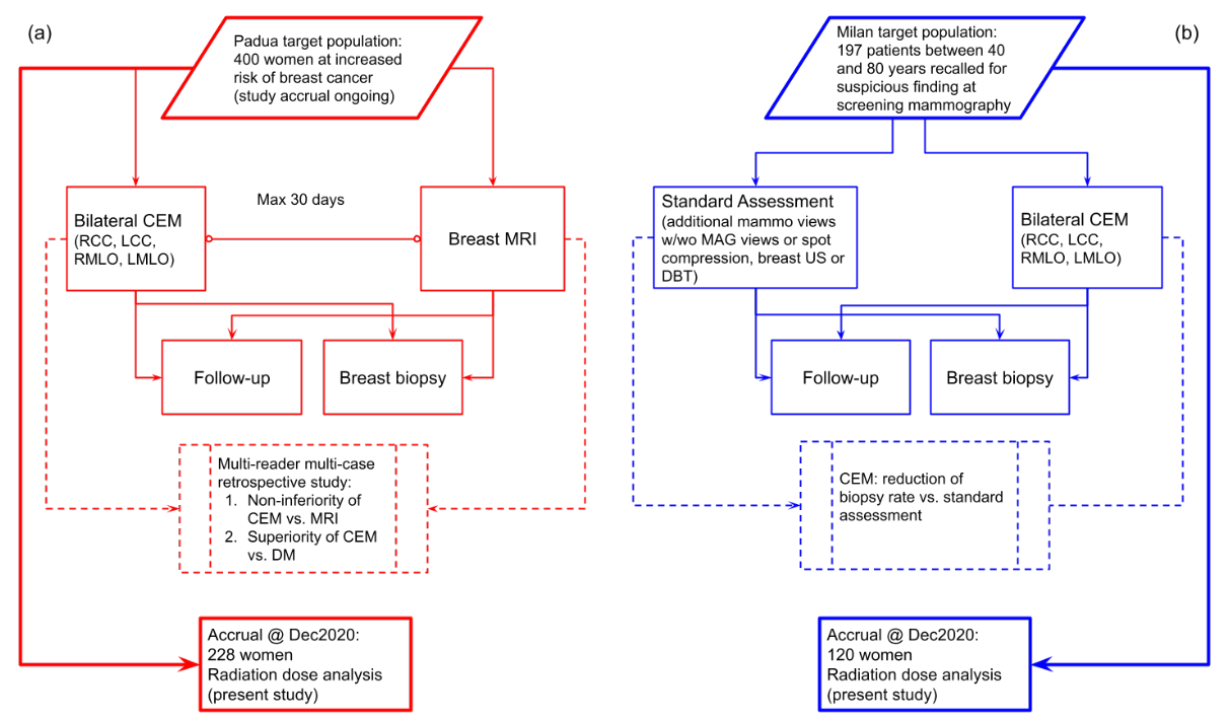
Figure 1. ( a ) Flowchart of the prospective study ongoing at Center 1 comparing CEM with breast MRI in a population of women at increased risk of breast cancer. ( b ) Flowchart of the prospective study at Center 2 using CEM as a work-up tool for suspicious findings detected at screening